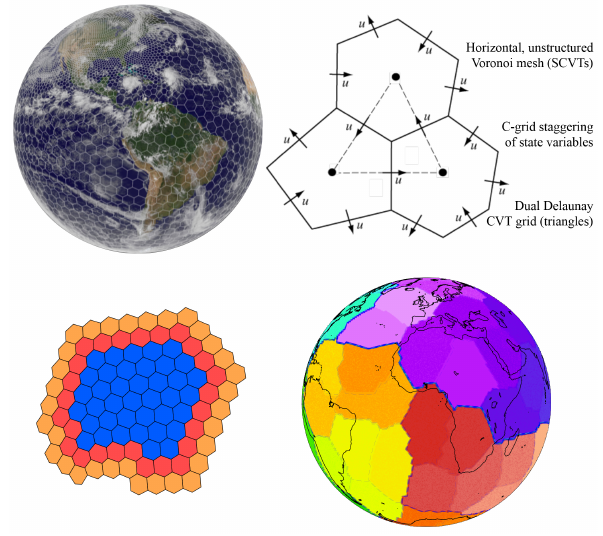
Figure 1. Upper left: sketch of a variable-resolution Voronoi mesh used for the horizontal grid; upper right: C-grid staggering of state variables (adapted from Skamarock et al., 2012); lower left: a block of owned cells (blue) assigned to an Message Passing Interface (MPI) task, along with two layers of halo cells (red, orange); lower right: partitioning of the regular 120km mesh with 40962 grid cells for 64